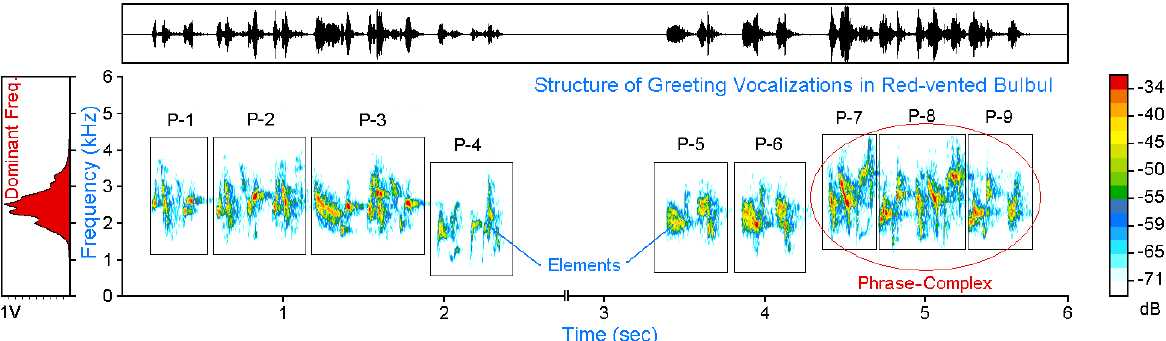
Figure 3. Physical characteristics and structure of vocalizations produced during Greeting Display.